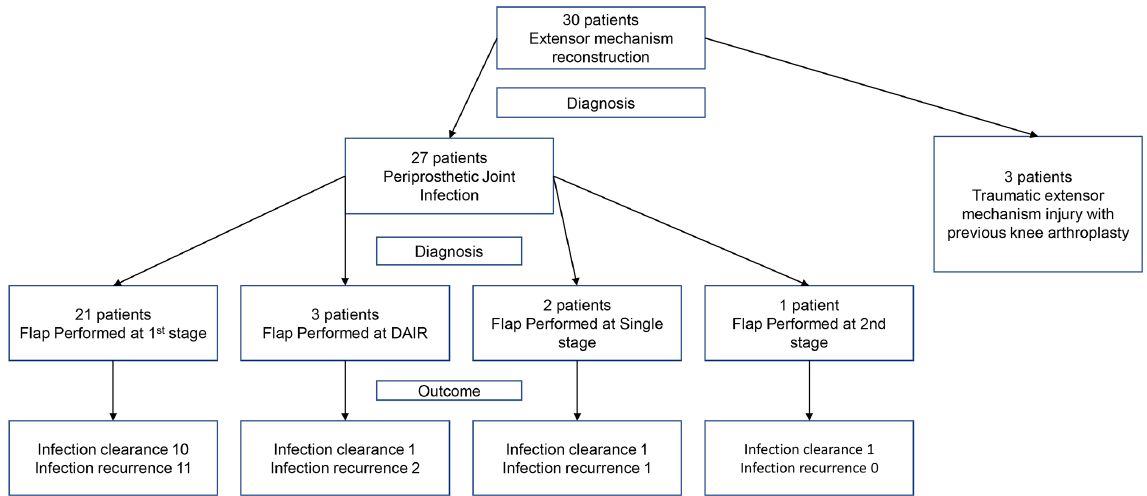
Figure 6. Flow diagram to represent patient procedures and outcomes for infection clearance.